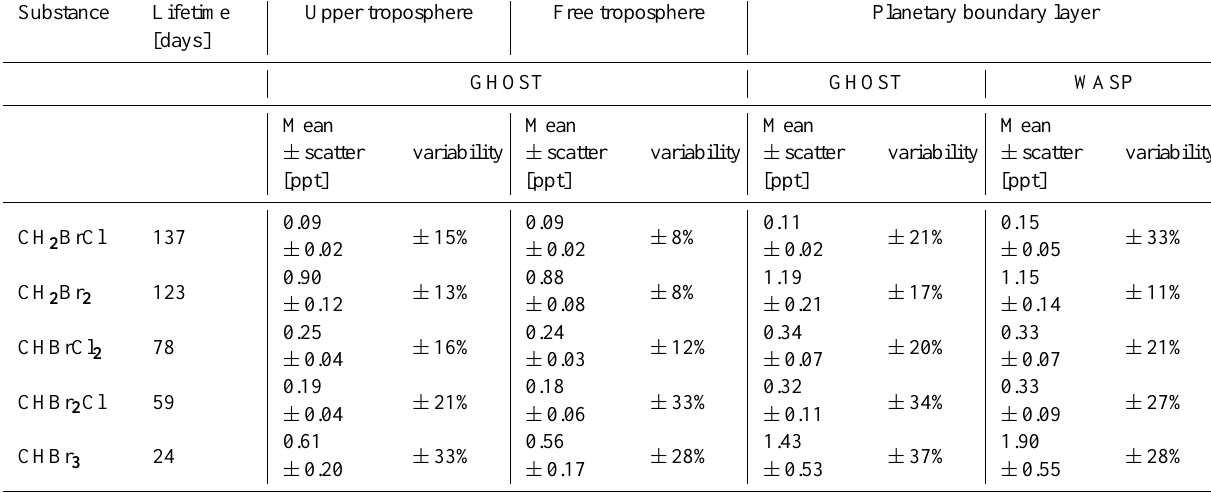
Table 4. Overview of the averaged mixing ratio of the VSLS in the upper and free troposphere and the planetary boundary layer. The scatter is the absolute standard deviation of all measurements for the given mean value. The (atmospheric) variability is calculated as given in Eq. (2). The lifetime is given for the free troposphere (Montzka and Reimann et al., 2011). For CH 2 BrCl, the data of flight 20111119a is not included in the calculation for the mean value in all three altitude ranges, as the mixing ratios during that flight are much higher (factor 2.5) than during the rest of the campaign (see also Fig. 5). Therefore we state that these high values are not representative for the mixing ratio of CH 2 BrCl during the campaign. For the calculation of the mean value of CH 2 Br 2 and CHBrCl 2 in the free troposphere, flight 20111119a is also not included for the same reasons (see Figs. 3 and